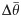
Error of the band-pass method and the AF method vs. the dispersion k of the fiber network.Fibers with a width of 5, aspect ratio of 30 and an image noise factor of 1 were considered here. (A) shows the error of the mean fiber orientation Δθ¯. Inlets show exemplary Monte-Carlo generated greyscale fiber images from respective distributions. (B) shows the relative error of the fiber dispersion parameters Δkrel, Δbrel. Sample greyscale images, that were simulated by the implemented Monte-Carlo method are shown for k = 0.01 and k = 5. (*p < 0.05, **p < 0.01, ***p < 0.001).